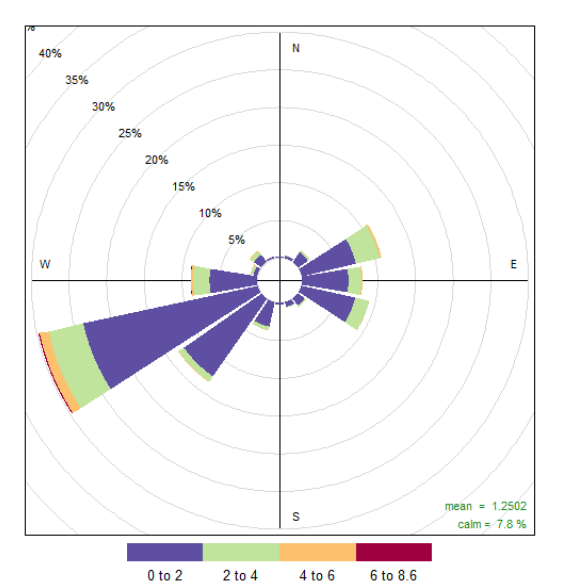
Figure 13. Wind rose that combines the measured wind speed with the predicted wind direction from the testing data set.